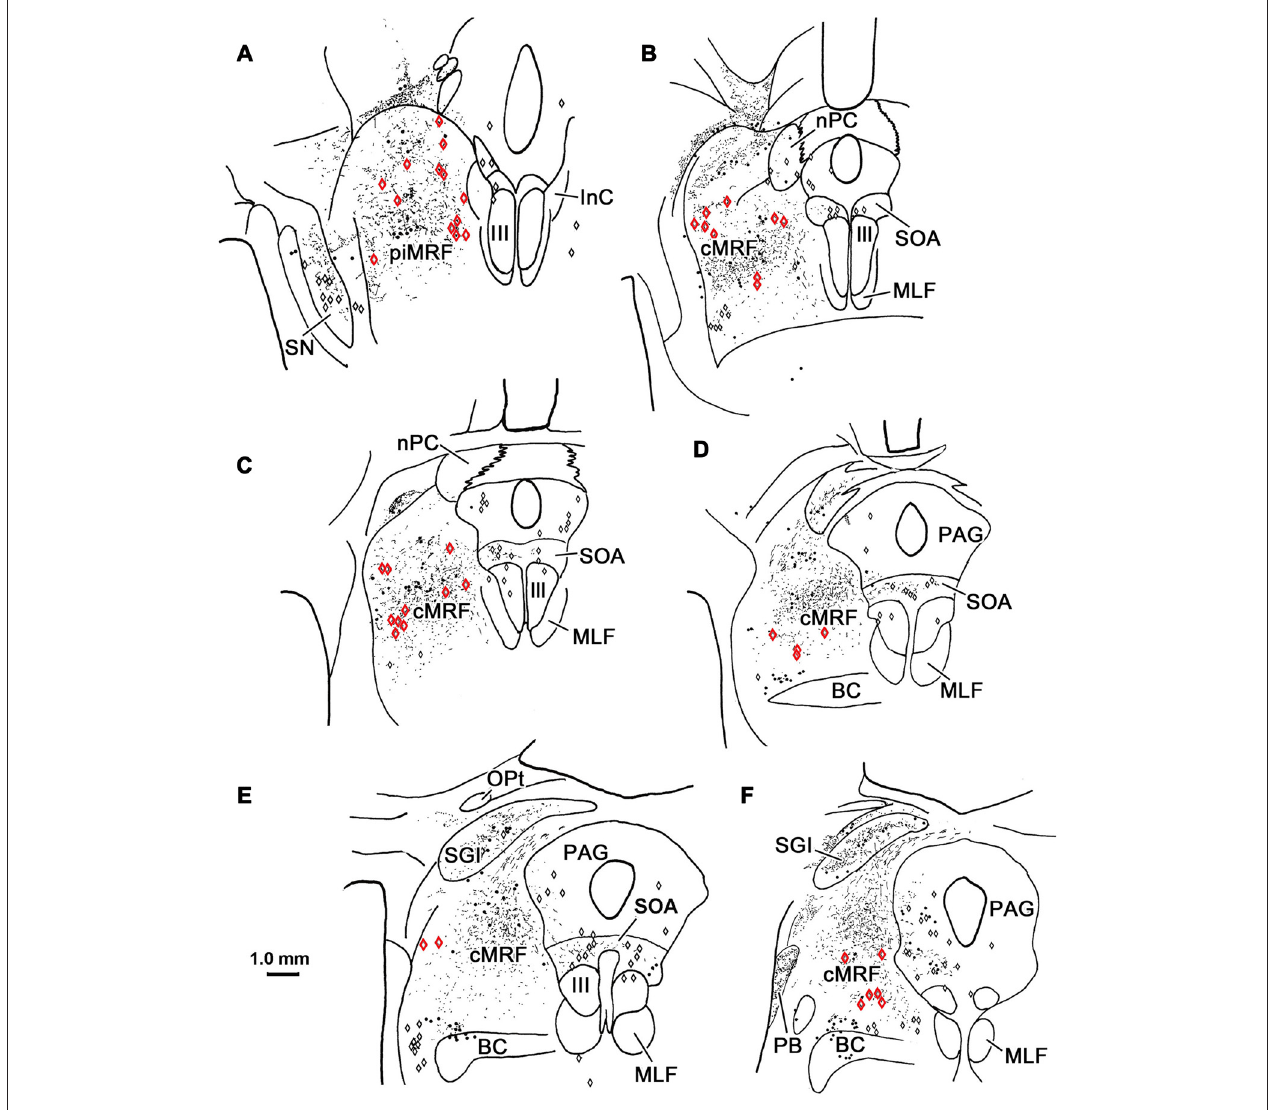
FIGURE 11 | Overlapping distribution of tectoreticular terminals and reticuloreticular neurons. The distribution of tectal terminals (stipple) labeled by BDA and reticuloreticular neurons (red diamonds) labeled by WGA-HRP that resulted from the injections illustrated in Figure 10 are shown for the ipsilateral midbrain reticular formation (MRF). Note the overlap in their distributions within the cMRF (B–F) and the piMRF (A) . The reticuloreticular cells were scattered amongst BDA labeled reticulotectal neurons (black dots) in the cMRF. Other WGA-HRP labeled cells are indicated by black